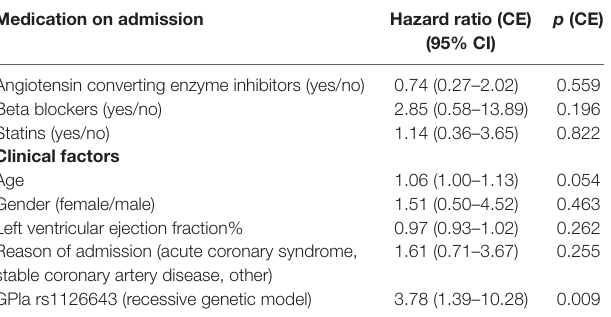
TaBle 6 | Cox regression analysis for the combined endpoint (CE) as dependent variable, rs1126643 (recessive genetic model) as independent variable, and clinical factors as covariates in the high-risk cohort ( n = 163).